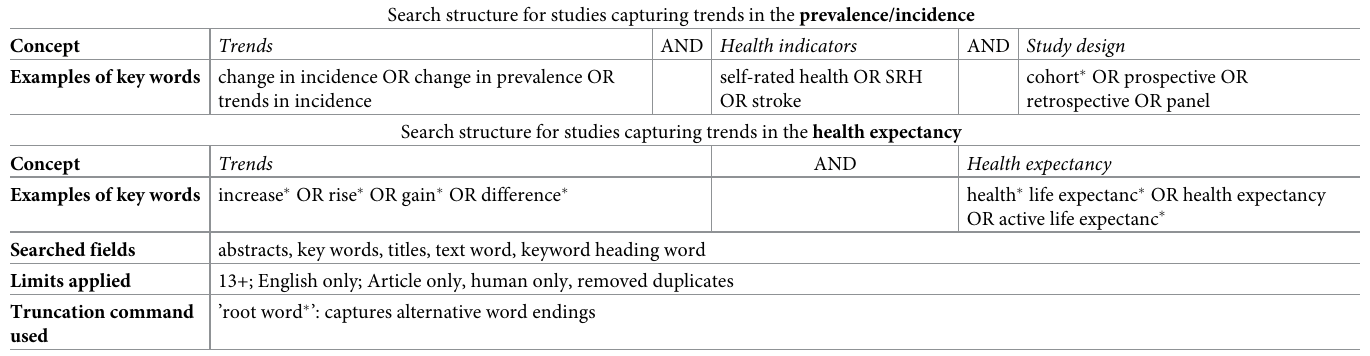
Table 2. The search strategy in OvidSP (including EMBASE AND